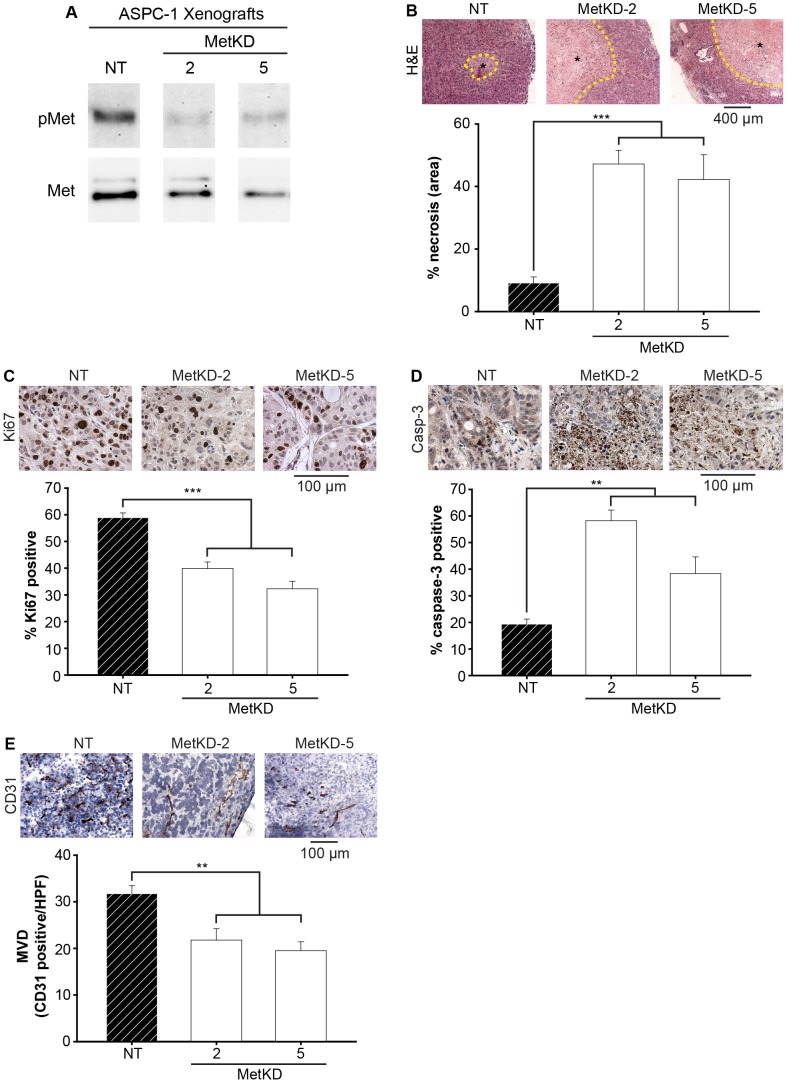
Decreased cell survival and tumor angiogenesis in ASPC-1 MetKD tumors.Immunoprecipitation and Western analysis detected strong phosphorylated Met (pMet) in NT tumors relative to low pMet levels in MetKD tumors (A). Serial sections of paraffin-embedded tumors were either H&E stained (B) or processed for Ki67 (C), active caspase-3 (D) and frozen sections for CD31 (E) staining. Morphometric analysis indicates a significant increase in necrosis and cleaved caspase-3 staining with a corresponding decrease in Ki67 and CD31 staining per high powered field (HPF) in MetKD tumors relative to NT tumors (**p<0.01, ***p<0.001; ANOVA). Representative field images are shown.